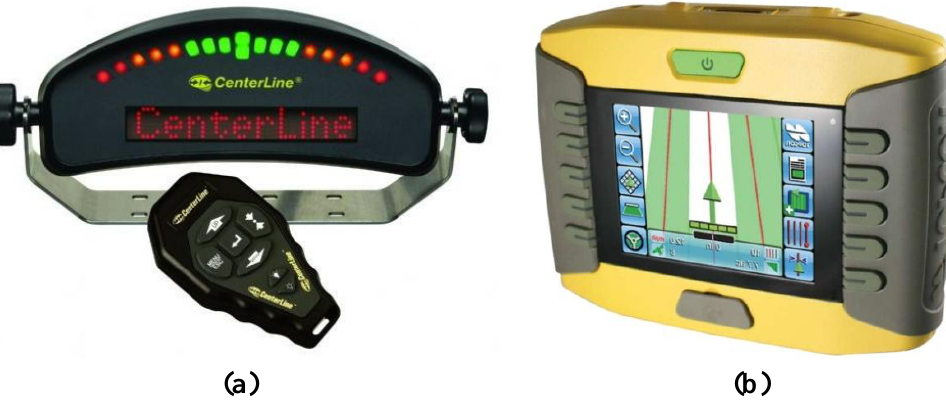
Figure 12. ( a ) Control panel of the Centerline Guidance Lightbar marketed by Teejet [24]. ( b ) Control panel of the 150 Tractor Guidance System manufactured by Topcon